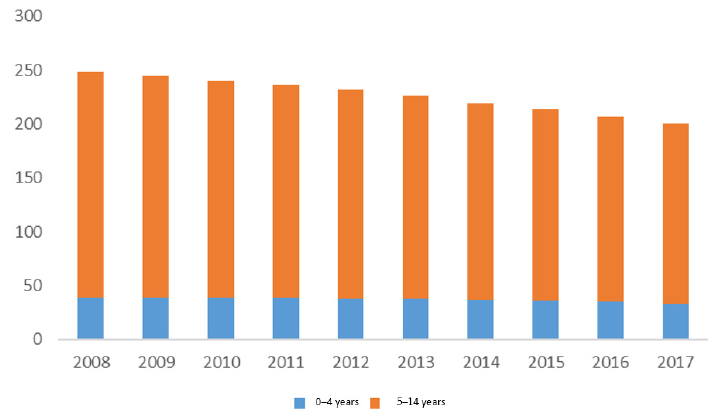
Figure 6. Years of Life Lost to Disability due to drowning by age group, Philippines 2008–2017. For the total burden of drowning among children aged 0–14 years in the Philippines, there were a total of 2,292,471.0 DALYs recorded across the study period. The DALYs burden is evenly split between the age groups, with 5–14 year olds accounting for 50.6% of the total burden. When examining trends over time, the unintentional drowning-related DALY burden declined for both age groups, with a more significant decline over the study period in the 0–4 years age group (y = − 2776.3x + 128512; R 2 = 0.8754) (Figure 7).